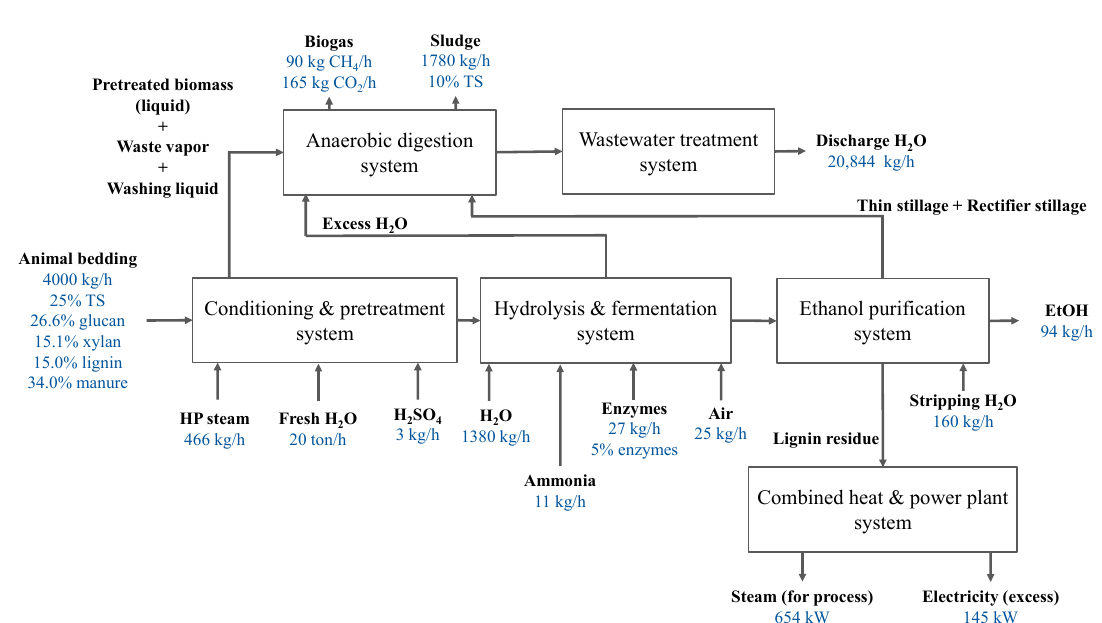
Figure 2. Mass and energy flows in the animal bedding biorefinery without water recycling, assuming a plant capacity of 1000 dry kg/h of feedstock.